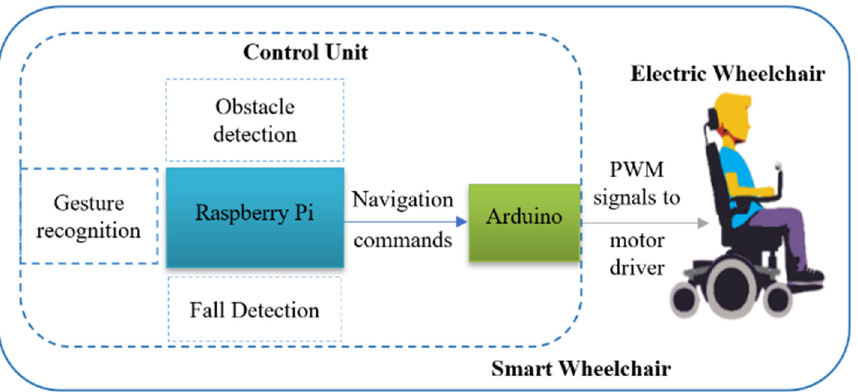
Figure 1. Simplified block diagram of the proposed smart wheelchair.